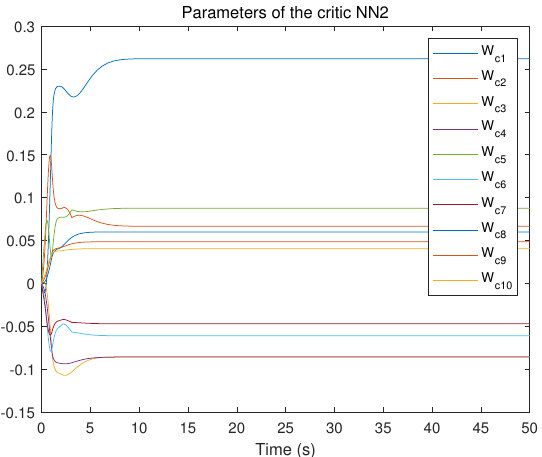
Figure 12. Convergence curves of critic NN2 weights for player 2.